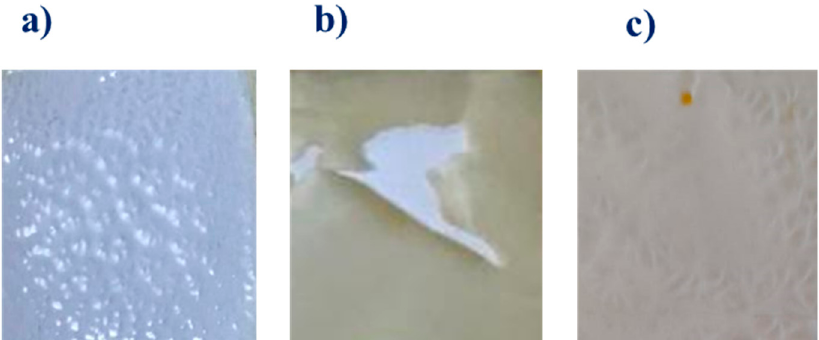
Figure 9. Photos for sections of PVC films: ( a ) blank PVC before irradiation, ( b ) blank PVC after irradiation, ( c ) blended PVC with PVC-ed/p-OH after irradiation. irradiation, ( c ) blended PVC with PVC-ed/p-OH after Microscopic Images to Study the Morphology of PVC Films